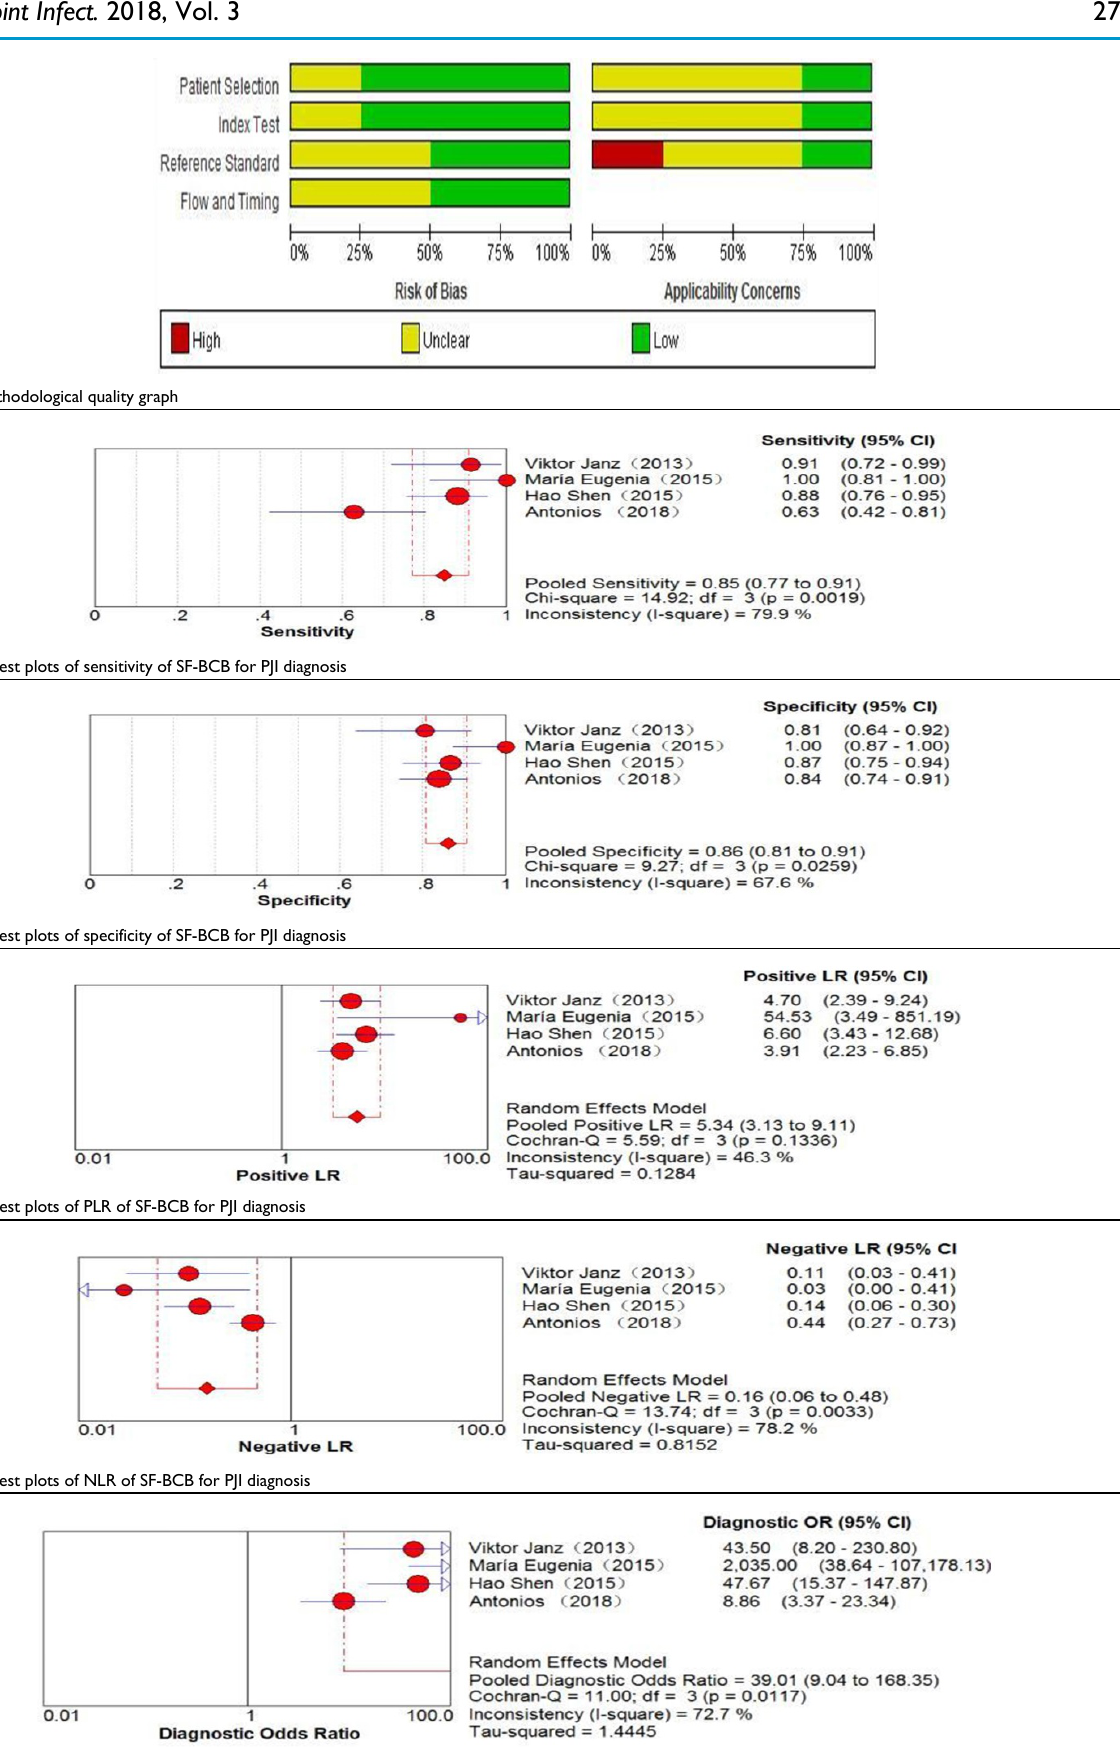
Figure 8. Forest plots of DOR of SF-BCB for PJI